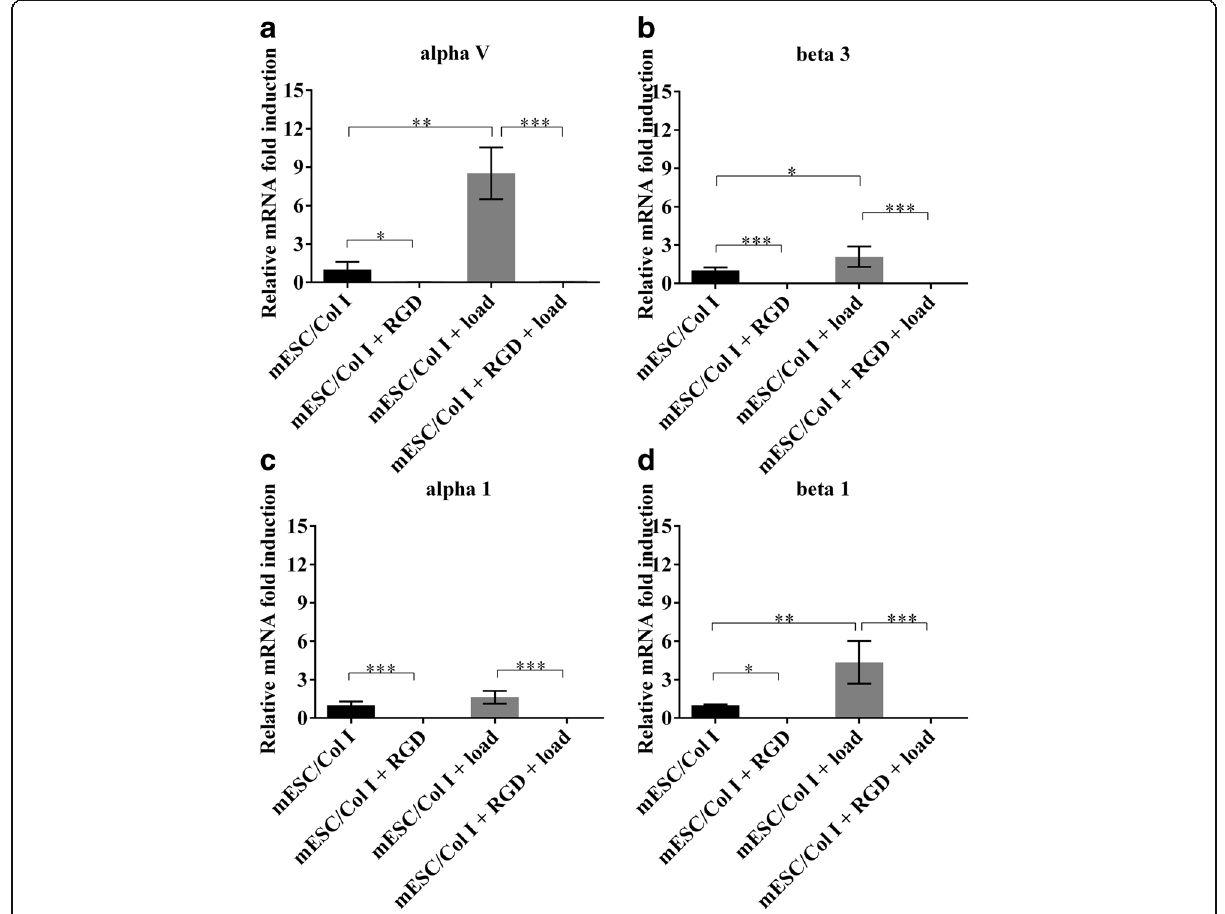
Fig. 2 Relative mRNA gene expression of RGD dependent integrin subunits ( a , b ) (alpha V and beta 3) and collagen dependent integrin subunits ( c , d ) (alpha1 and beta1) in response to the presence of cRGDfC peptide and/or compression. Mean ± SD, n = 3 independent experimental replicates. (***;p < 0.0001; **;p < 0.001; *;p <